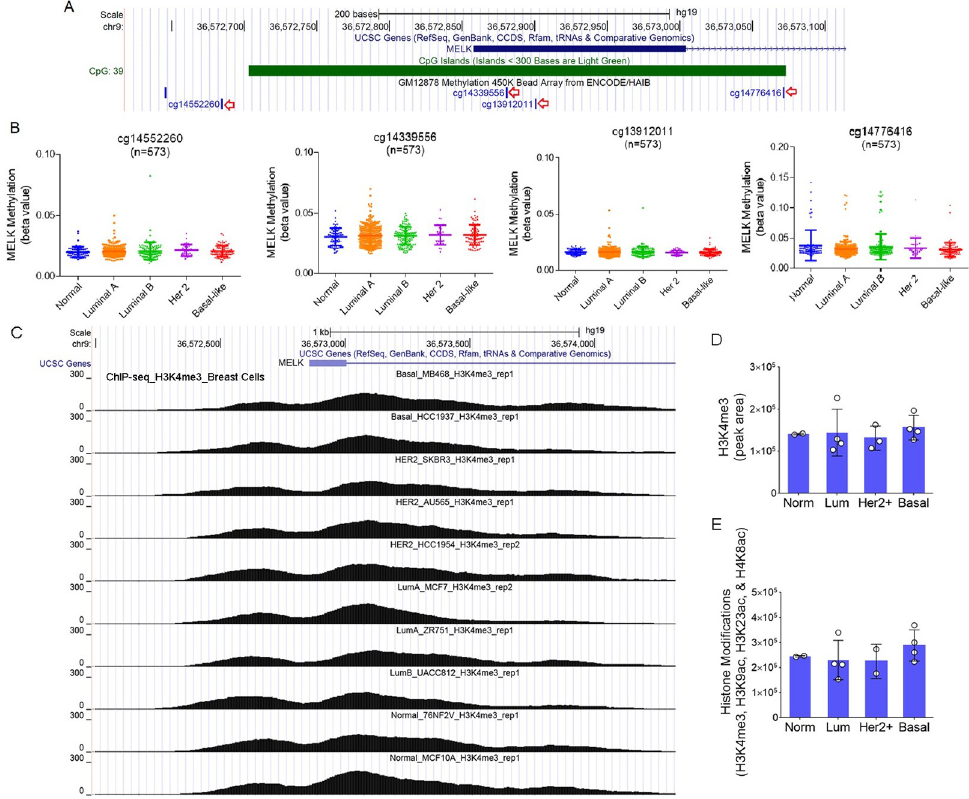
Fig 2. Epigenetic regulation of the MELK promoter in breast tumors. (A) The UCSC genome browser shows the location of CpG islands in the MELK promoter at chromosome 9p13.2. The four CpG dinucleotides located closest to the transcription start site were selected for analysis and are indicated by red arrows. (B) Analysis of TCGA HumanMethylation450 Array data showed no difference in CpG site methylation among breast cancer subtypes. Beta values (0 to 1) are relative values increasing from hypomethylation to hypermethylation. (C) ChIP-seq data for H3K4me3 in breast cancer cells were visualized through the UCSC genome browser (chr9:36,571,990–36,574,891). Each peak represents the level of H3K4me3 modification in each cell line. (D and E). The levels of H3K4me3 (C) and other histone modifications (H3K4me3, H3K9ac, H3K23ac and H4K8ac combined) (D) were calculated as a total peak area (Y-axis, details in the methods) and compared by molecular subtype. No significant differences in histone modifications were observed among breast cancer subtypes.